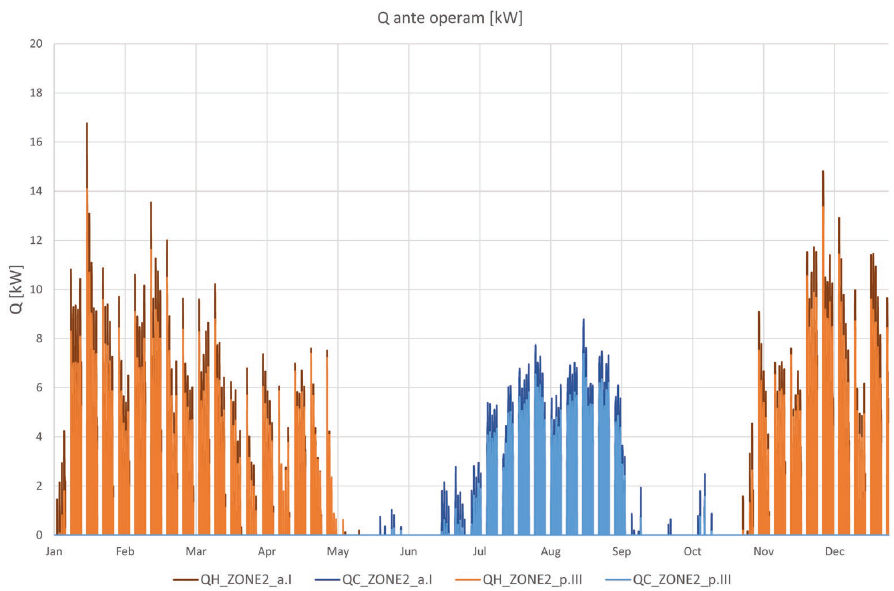
Figure 9. Annual distribution of instantaneous power: current and designed configuration p.IV (floor 2).